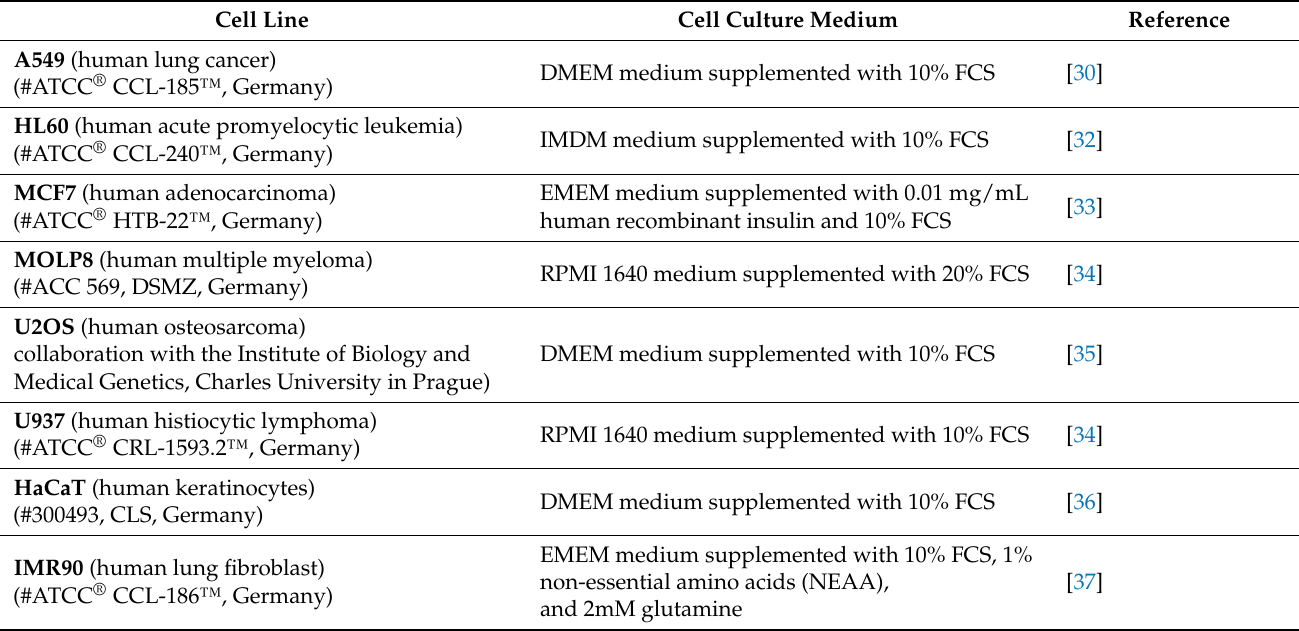
Table 1. Conditions of the cultivation of selected tumor cells and non-cancerogenic cell